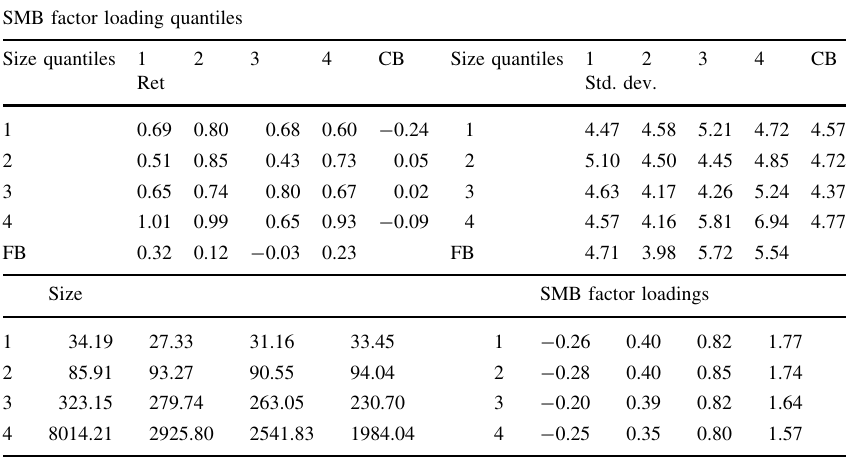
Table 9 Average monthly returns for portfolios formed from sorts on size and SMB slopes SMB factor loading